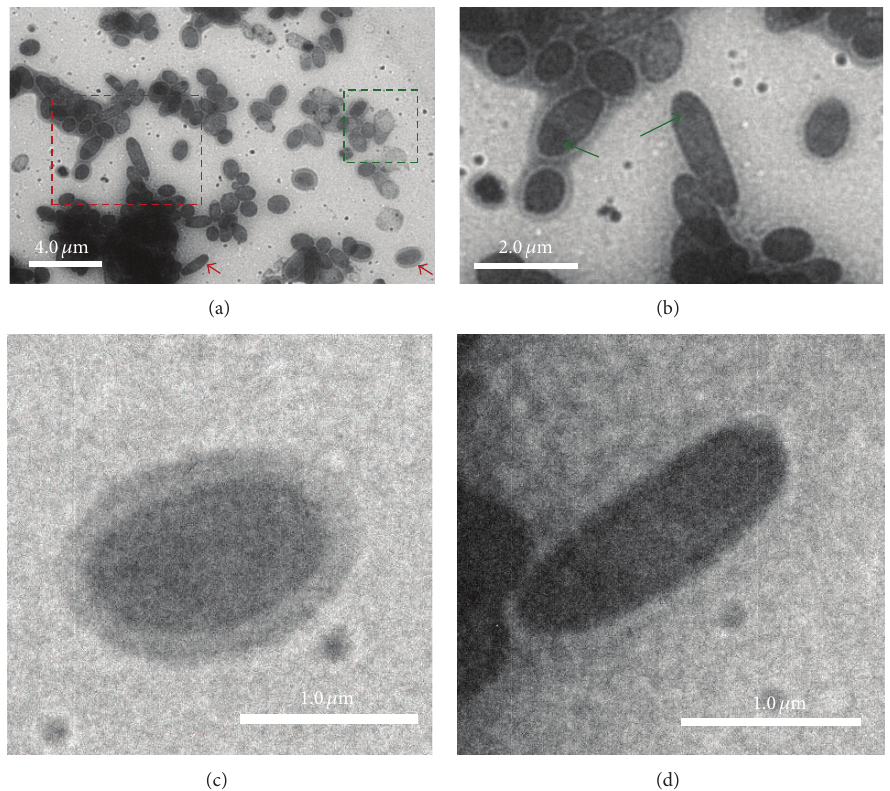
Figure 1: In situ TEM images of E. coli cells in the liquid chamber. (a) Larger area in situ TEM image. (b–d) Magnifications from (a): (b) the red rectangle labeled region in (a) in which two E. coli cells showed dim dark centers as highlighted by the green arrows; (c) an E. coli with apparent pili around the cell; (d) an E. coli without apparent surrounding pili. (c) and (d) displayed the cells indicated by the red arrow heads in